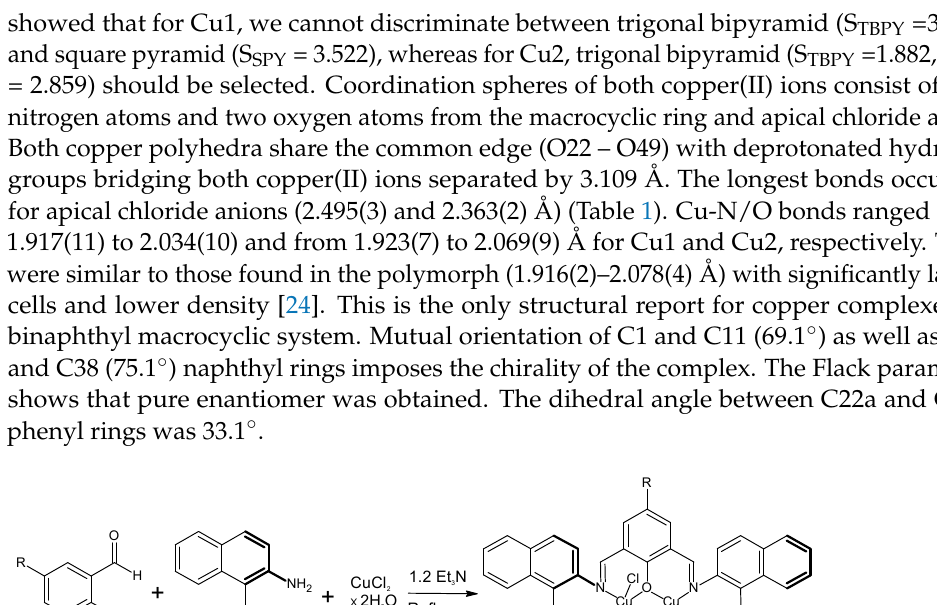
Figure 2. Structure of [Cu 2 Cl 2 (L’)] K1 with a numbering scheme and thermal ellipsoids at 30% probability.